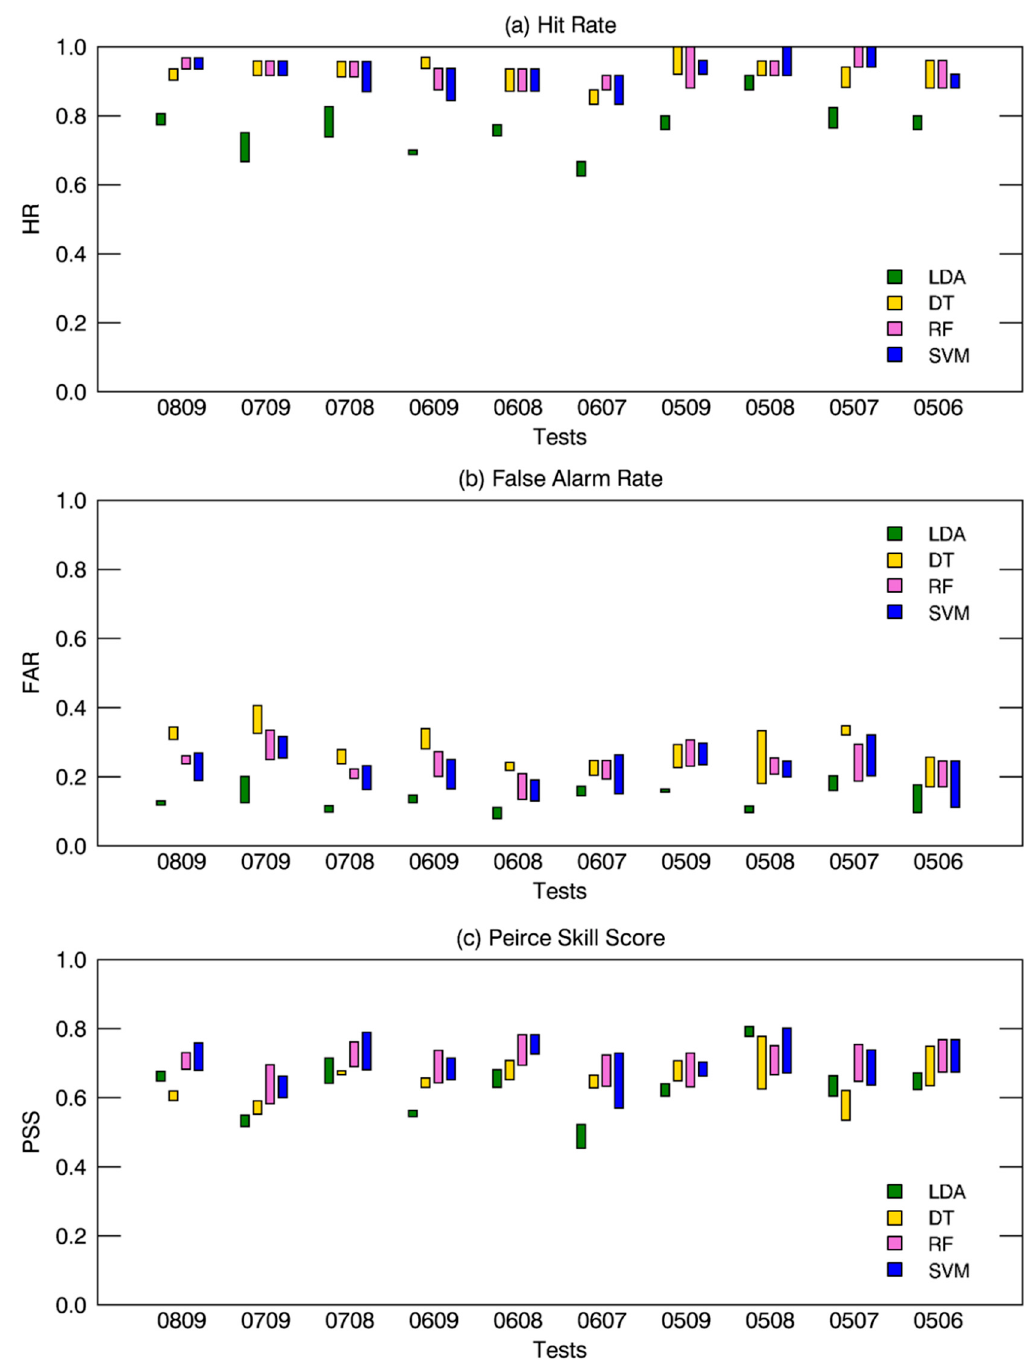
Figure 6. Forecast verification of ( a ) hit rate, ( b ) false alarm rate, and ( c ) Peirce skill score for LDA (green), DT (yellow), RF (pink), and SVM (blue) from validation sets denoted on the x-axis. The upper and lower bounds of each bar represent 90 and 10 percentile values, respectively.